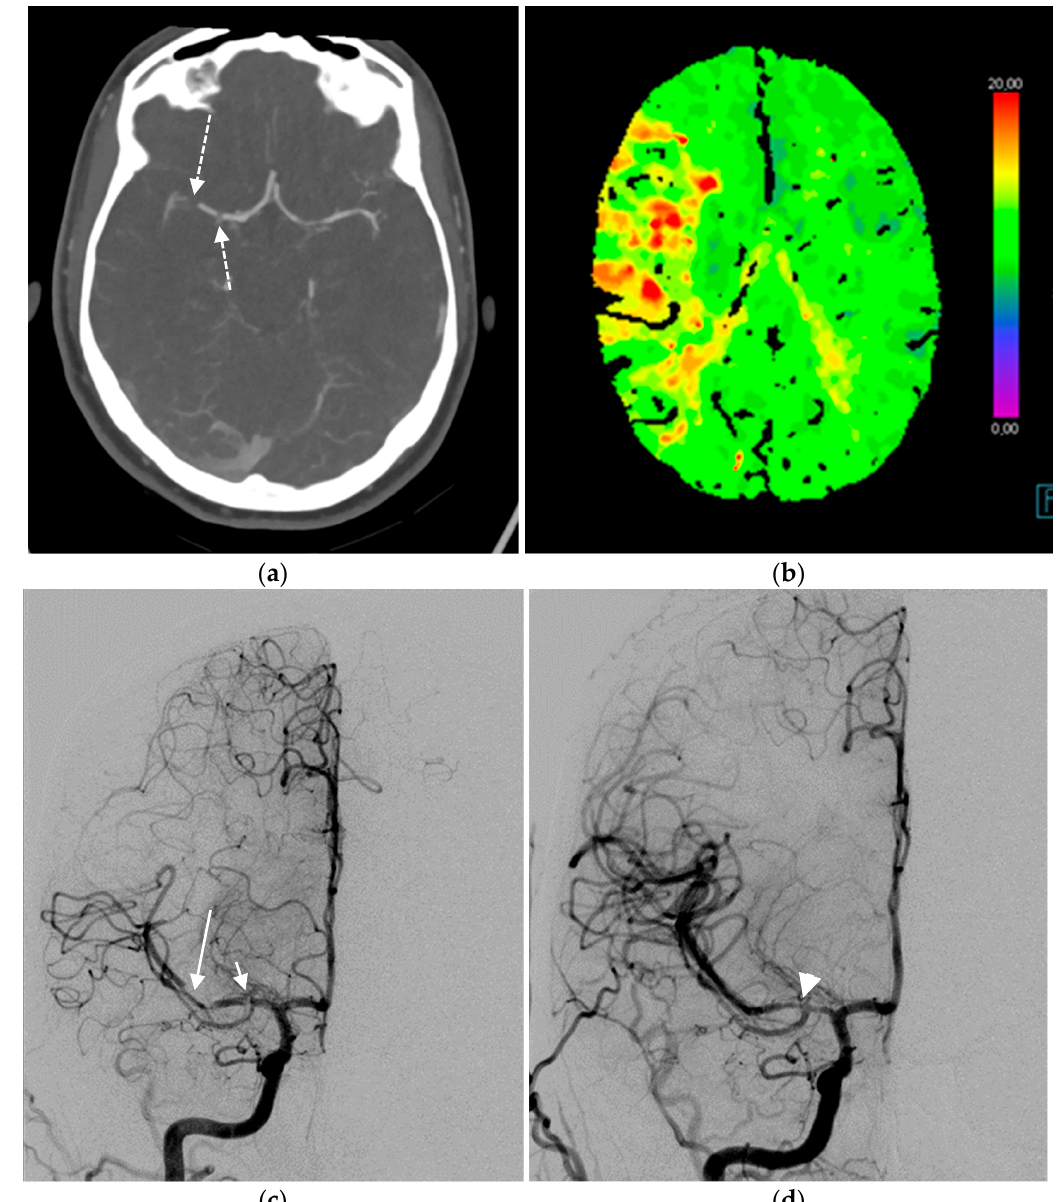
Figure 3. A 17-year-old female with acute ischemic stroke. The CTA showed an occluded right middle cerebral artery (dashed arrows, ( a )) and increased time to peak perfusion maps in the corresponding area of the brain ( b ). The DSA showed two emboli in the course of the right middle cerebral artery ( c ). The shorter one (3 mm) was located in the middle of the M1 segment (short arrow), while the longer one (10 mm) was located in the distal part of the M1 segment, extending into the M2 segment (long arrow). Both emboli were removed through mechanical thrombectomy ( c ). Moderate vasospasm (arrowhead) was seen immediately after the removal ( d ) and subsequently subsided in a matter of minutes.